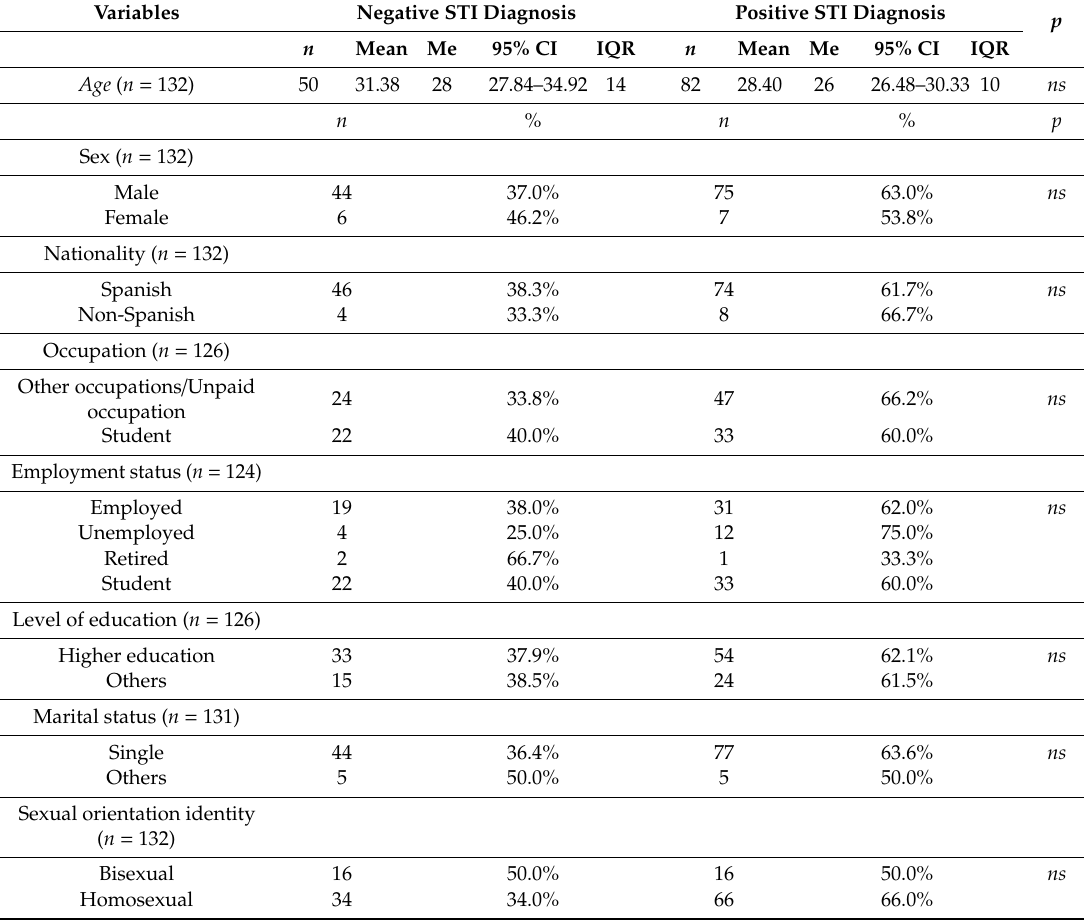
Table 2. STI diagnosis vs. Socio-demographic characteristics.